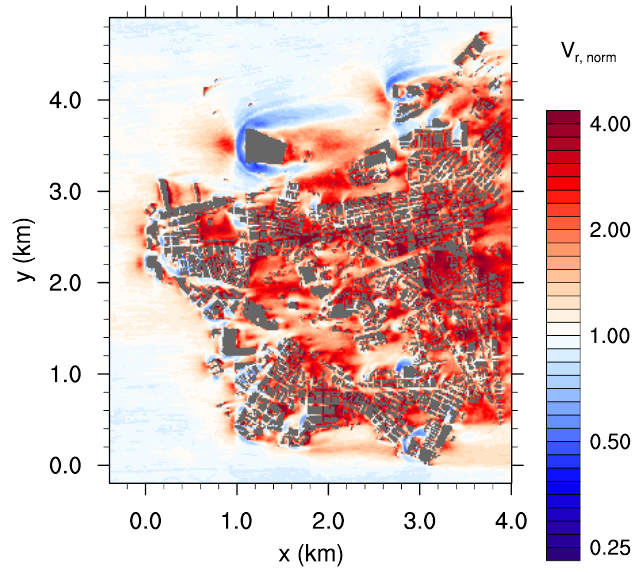
Figure 6. Normalized velocity ratio V r ,norm . Values above 1 indicate higher V r in the unstable case, while values below 1 indicate higher V r in the neutral